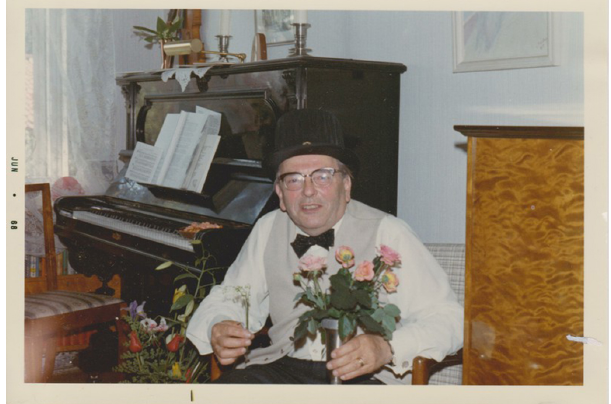
Figure 2. Willy Stoffregen at a celebration in his house after the award ceremony of the honorary doctorate of Uppsala University 1968.